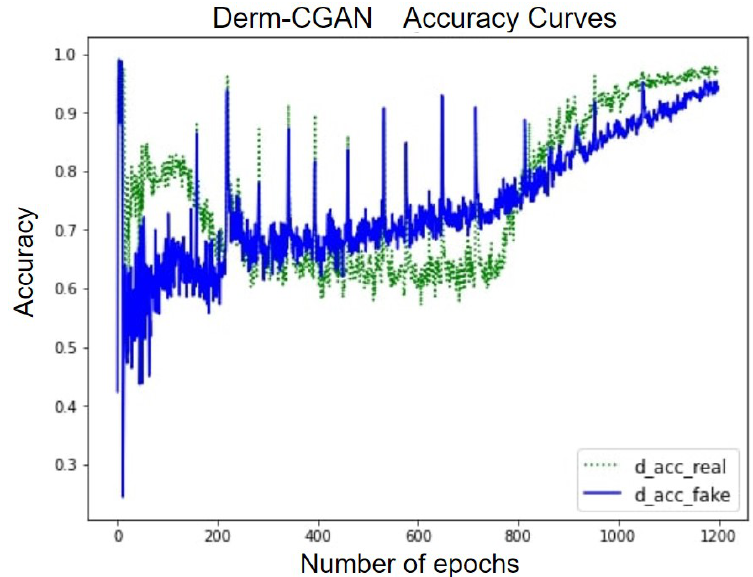
Figure 10. Accuracy curves of the discriminator on real and fake batches.